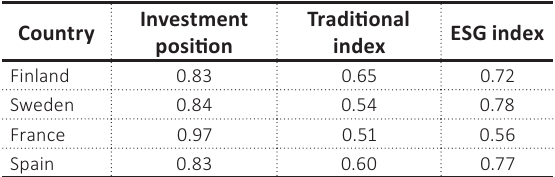
Table 7. R/S analysis of countries’ investment positions, ESG and traditional indices